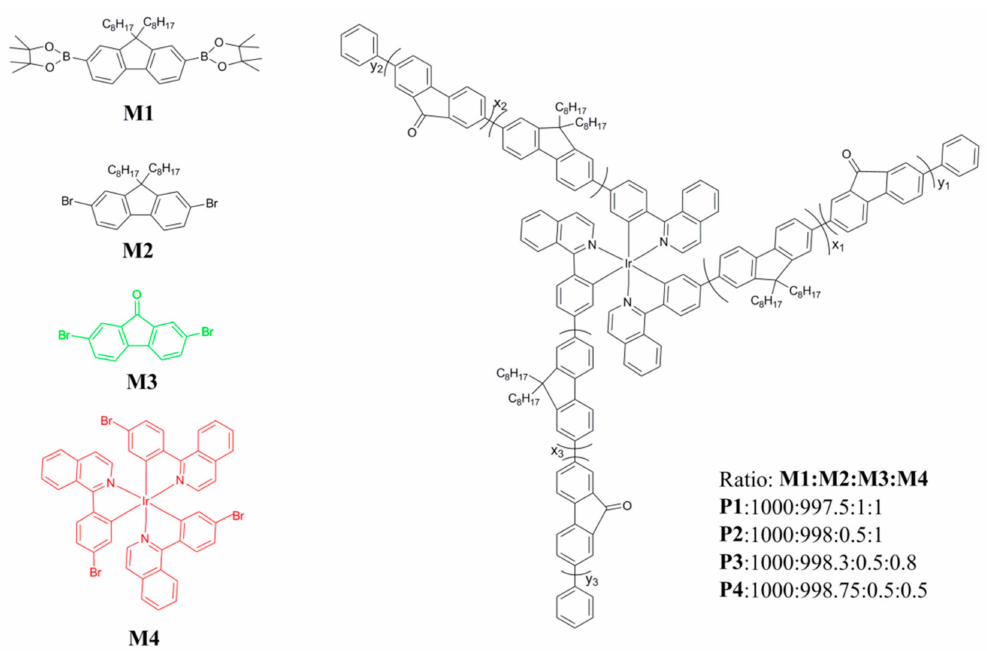
Figure 1. The chemical structures of the monomers and star-shaped white-emission